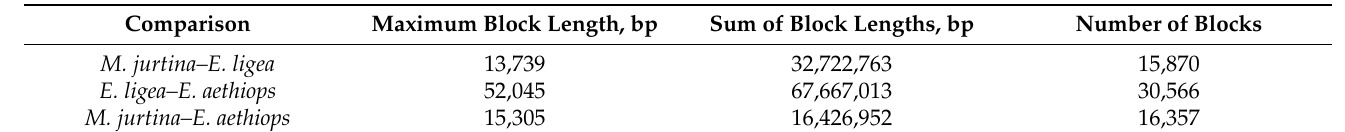
Table 2. Properties of pairwise alignments (i.e., syntenic blocks) of the Satyrinae whole-genome assemblies after filtration.